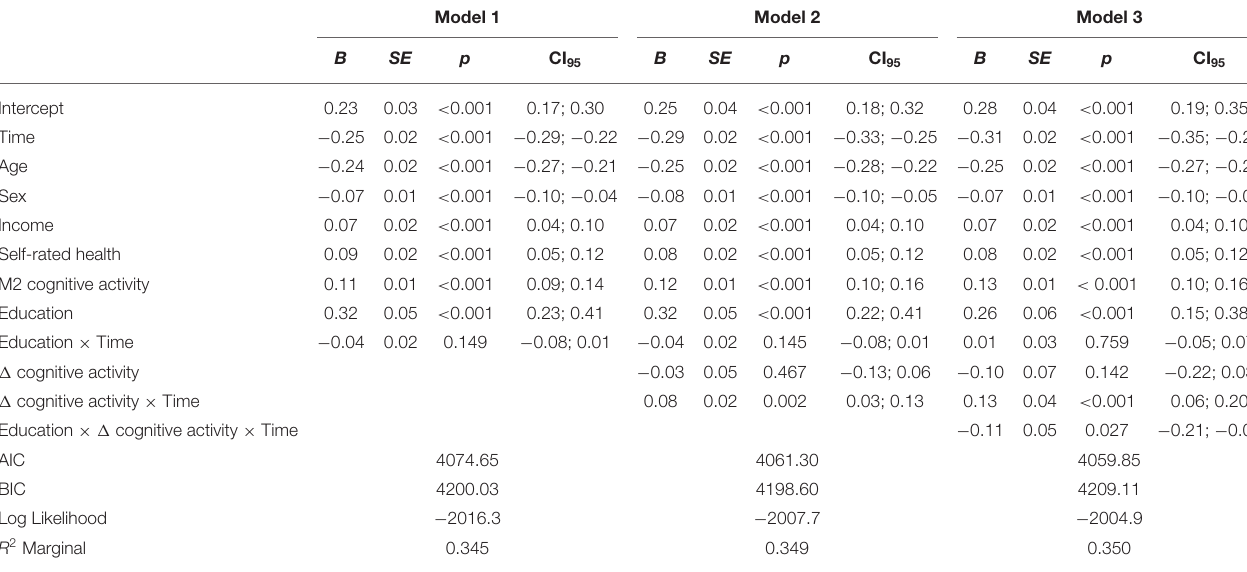
TABLE 2 | Effects of change in cognitive activity and education on change in executive functioning (EF) with covariates a